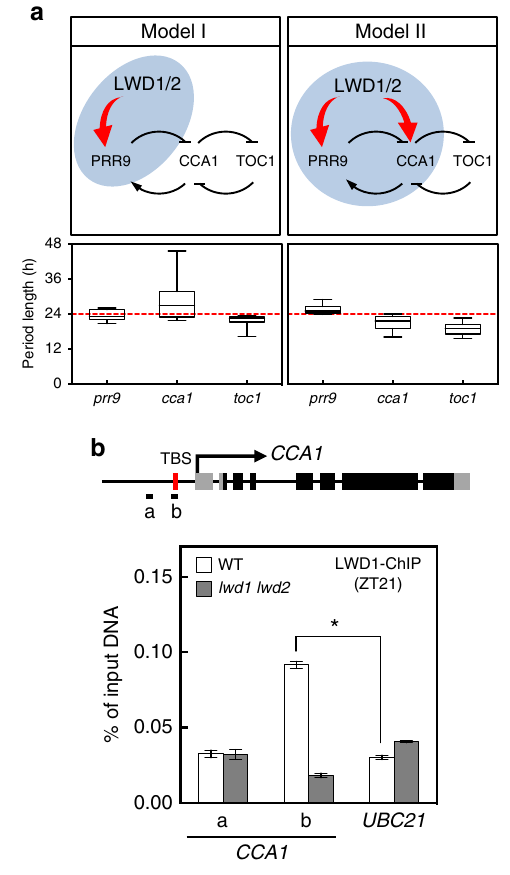
Figure 1 | LWD1 functions as an activator in the circadian clock. ( a ) Proposed models for the role of LWD1 in activating the Arabidopsis clock system via PRR9 (Model I) or both PRR9 and CCA1 (Model II). The box plots show period lengths simulated under the representative genetic perturbations ( prr9 , cca1 or toc1 ) in these two models, with the wild-type model period being 24h. The period lengths were calculated from a good majority of the parameter sets obtained (See Supplementary Note 1 for details). Horizontal lines are medians, box edges are interquartile range and whiskers are minimum and maximum. ( b ) LWD1 associates with the CCA1 promoter in vivo . Diagram shows the gene structure of CCA1. Transcriptional start and exons are marked with arrow and boxes. Black boxes illustrate the coding region. Amplicons ‘a’ and ‘b’ for ChIP-qPCR assays are marked by horizontal black bars. ChIP assays involved use of the anti-LWD1 antibody at ZT21. UBC21 was a negative control. Data are mean ± s.d. ( n ¼ 3 technical replicates). Asterisk indicates that LWD1 preferentially binds with the amplicon ‘b’ in the wild type (Student’s t test; * P o 0.001). Similar results were observed in three independent experiments. NATURE COMMUNICATIONS|7:13181|DOI: